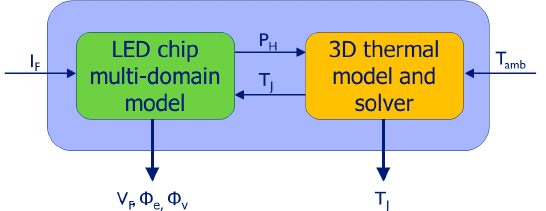
Figure 2. A chip-level multi-domain LED model embedded in a thermal simulator using a relaxation type iteration in order to realize an electro-thermal-optical solver used for the virtual prototyping of luminaires based on single-chip LED packages [27,29,31]. For the explanation of symbols used in this figure see the Abbreviations.